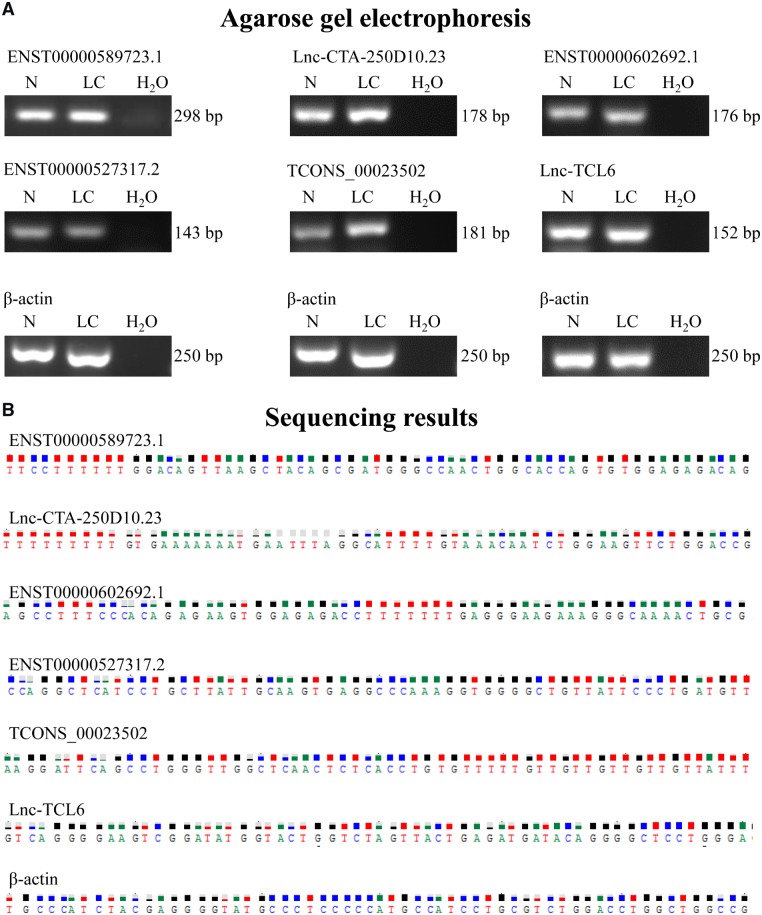
Agarose gel electrophoresis and sequencing results of six candidate lncRNAs. (A) PCR products of the candidate lncRNAs could be readily resolved by agarose gel electrophoresis. (B) Sequencing results showed that the expression of candidate lncRNAs in the whole blood of patients with HBV-related liver cirrhosis could be specifically detected by qRT-PCR in the training phase.